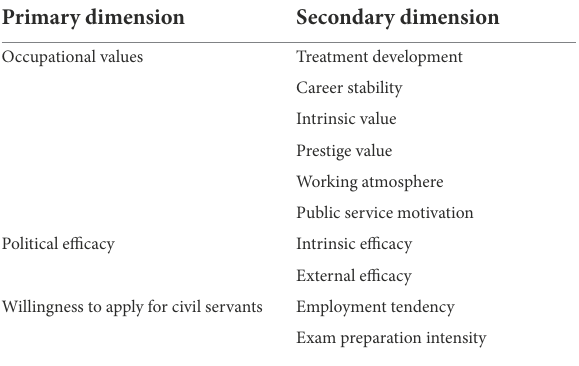
TABLE 2 Theoretical construction of questionnaire dimension. Primary